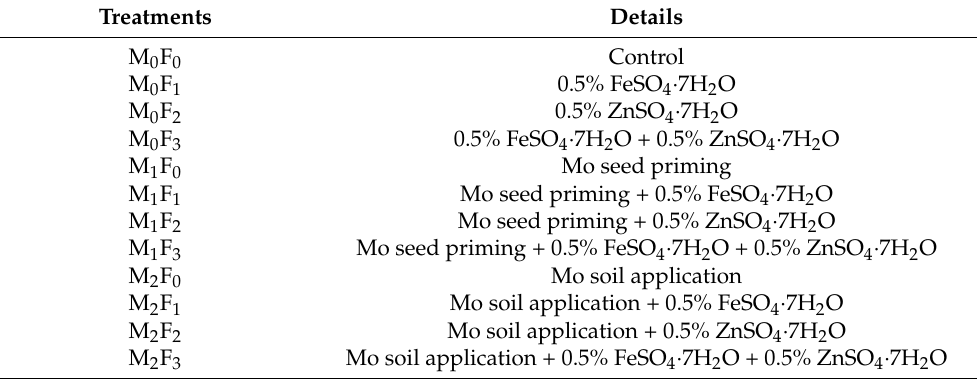
Table 1. The experiment was laid out in a split-plot design with three replications. Table 1. Treatment details of the field experiment.